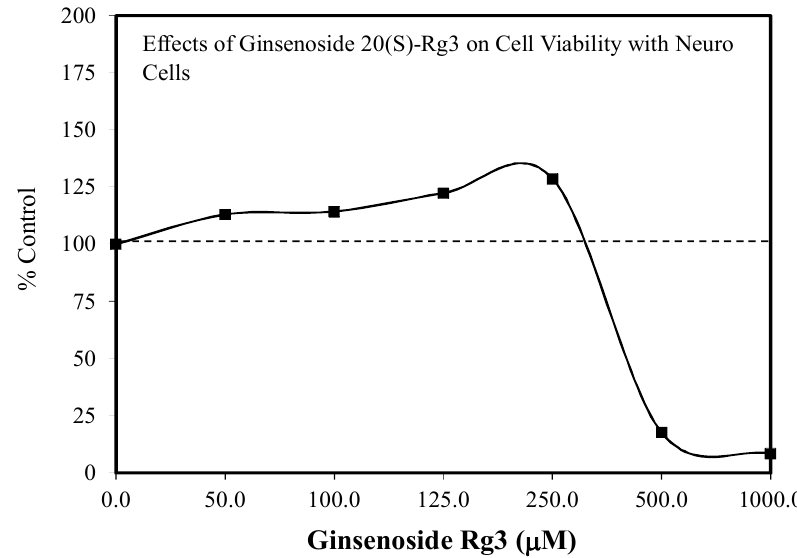
Figure 36. E ff ects of ginsenoside Rg3 on cell viability of H722 cells, a hippocampal neuronal cell line (source: [106]). Each * represent statistical significance for a data point.